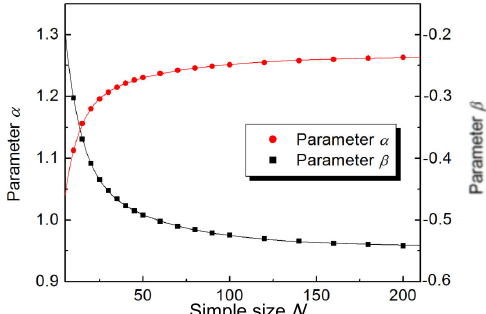
Fig. 6 Sample-size dependence of the mean value and the standard deviation of / m m estimated with the simple es tr method and the LS method ( m = 10). tr